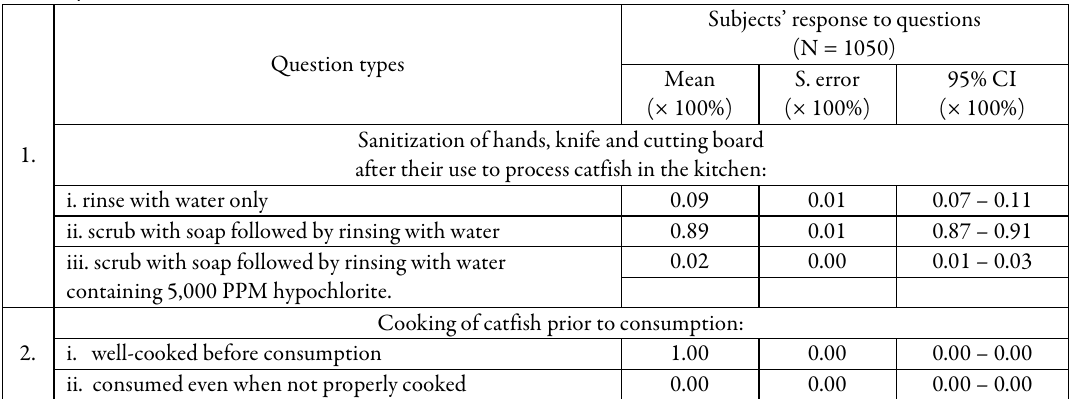
Table 2. Risk mitigation behaviors of human consumers during C. gariepinus processing in kitchen systems